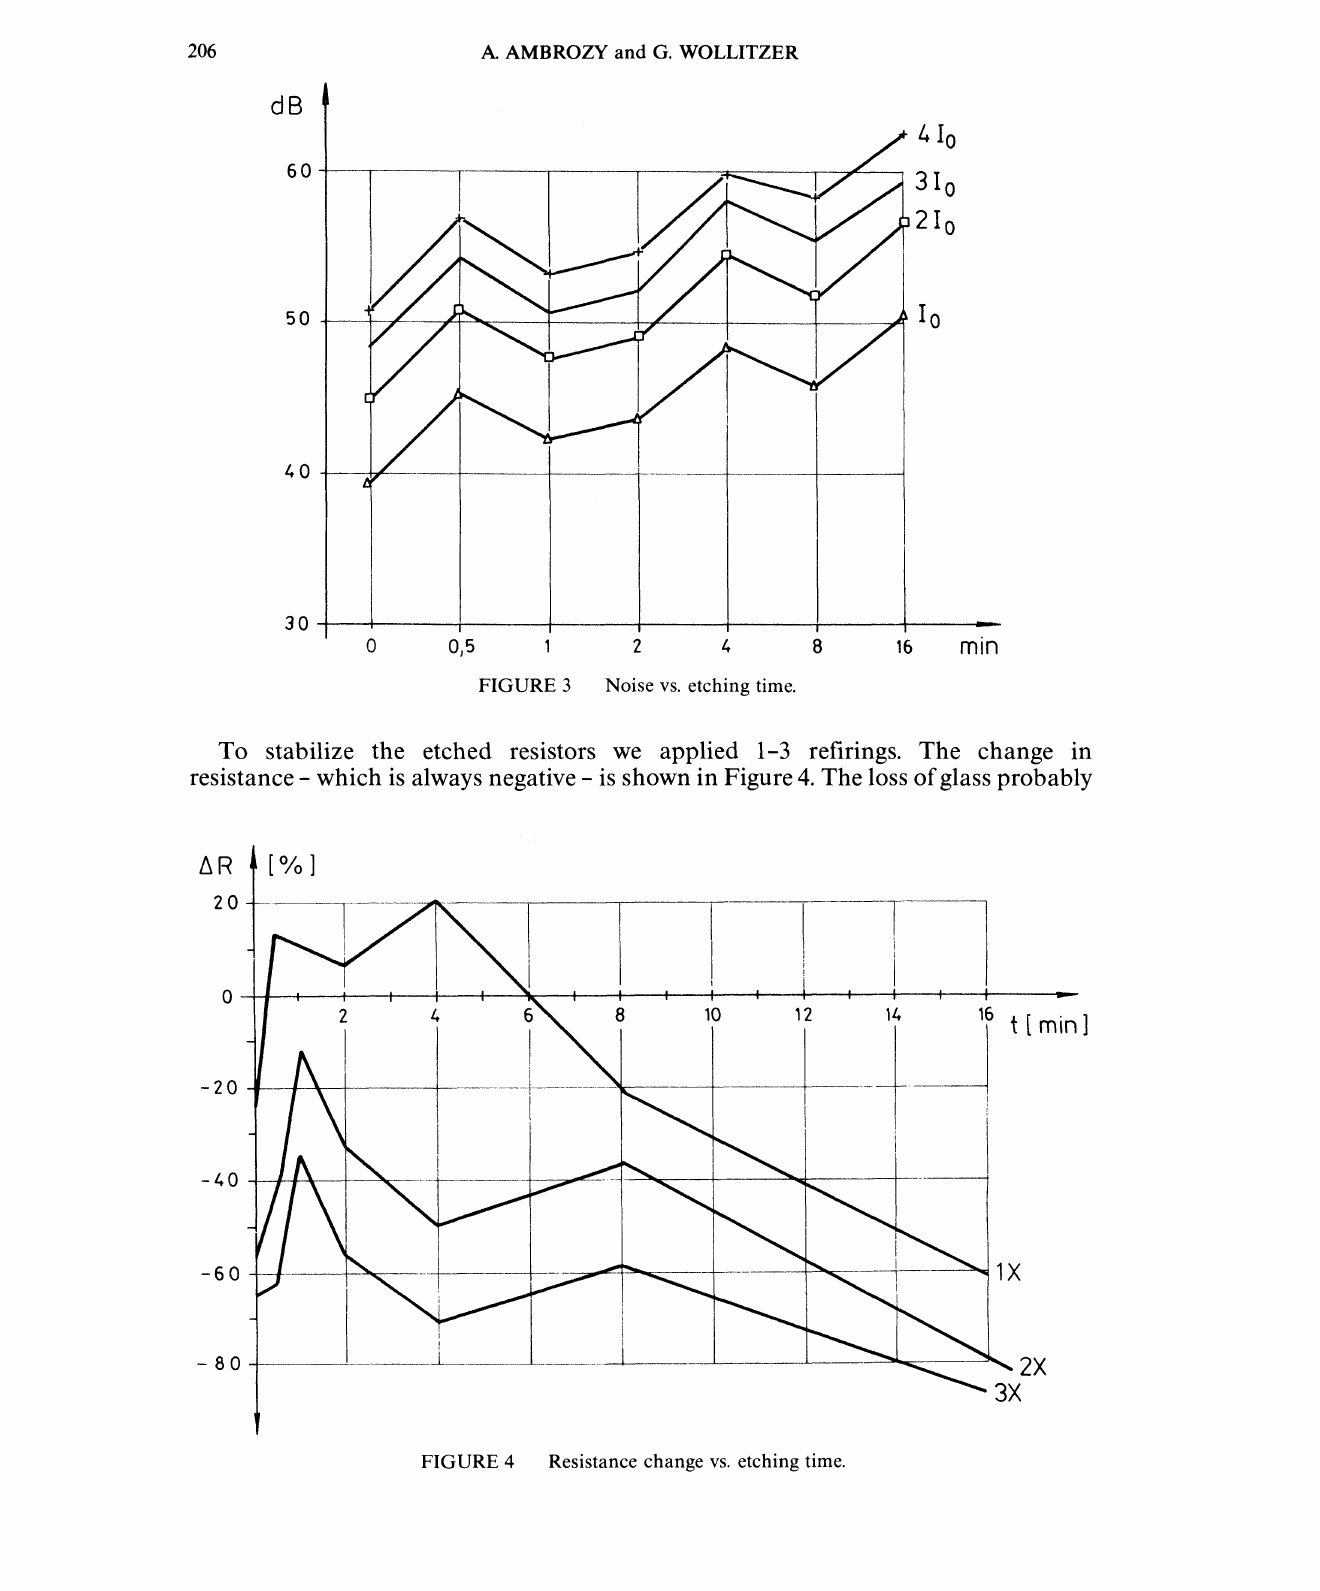
FIGURE 4 Resistance change vs. etching